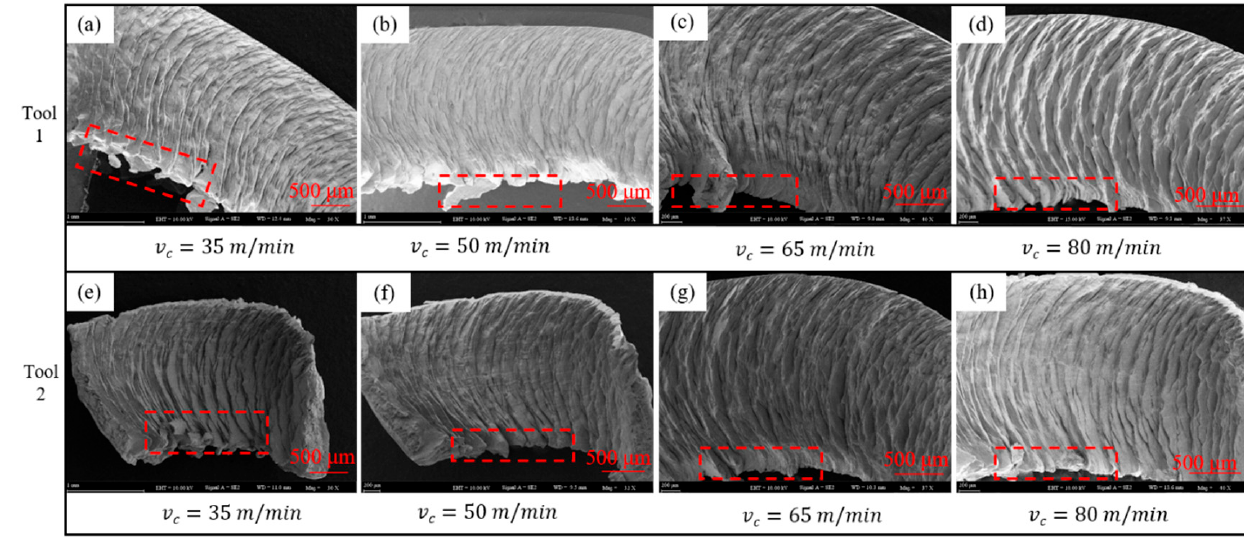
Figure 9. Comparison of chip burr after turning with Tool 1 and Tool 2: ( a – d ) the chip burr of Tool 1 at cutting speeds of 35, 50, 65 and 80 m/min, re-spectively, ( e – h ) the chip burr of Tool 2 at cutting speeds of 35, 50, 65 and 80 m/min, respec- tively.